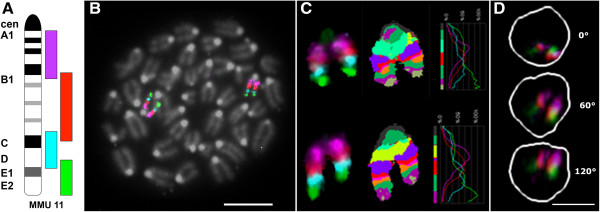
mBAND labeling scheme, metaphase of PreB lymphocytes of BALB/c origin, mBANDed chromosomes 11 and representative [T38HxBALB/c]N wild-type B cell interphase nucleus. A mBAND labeling scheme of mouse chromosome 11. Chromosome 11 is divided into four overlapping segments. Each segment was labeled with a different fluorochrome: the telomeric end in FITC (green), the centromeric end in Texas Red (magenta), and the interstitial segments in DEAC (cyan blue) and Gold (red), respectively. B Metaphase from diploid mouse Pre B lymphocytes of BALB/c origin after hybridization with the chromosome 11 mBAND probe. (Scale bar: 10 μm). C Two chromosome homologs from a different Pre B lymphocyte metaphase showing (from left to right) display colors, false colors and mBAND fluorescence intensity profiles. D Maximum intensity projections of a representative [T38HxBALB/c]N wild-type B cell interphase nucleus, from top to bottom: xy-view (z-projection), 60° and 120° rotation around the y-axis (note: the DEAC labeled probe is not shown because of insufficient signal/noise ratio of the FISH signal. The white line outlines the DAPI stained nucleus). (Scale bars are 5 μm).